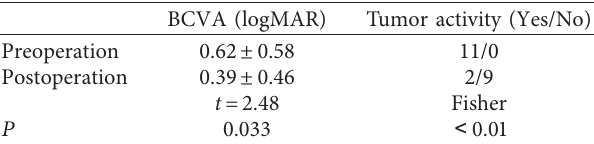
Table 3: Comparison of BCVA and tumor activity of preoperation and